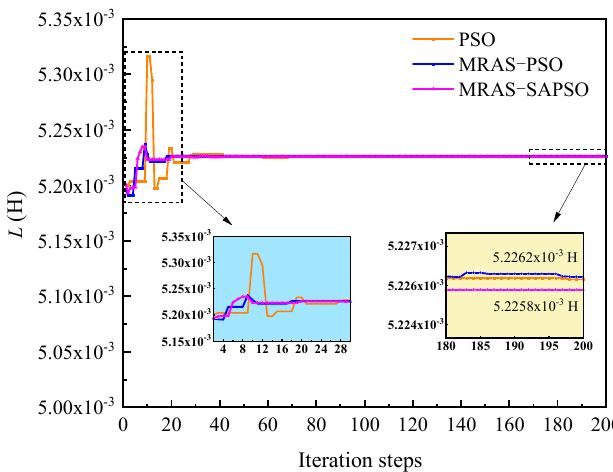
Figure 5. Inductance identification curve.